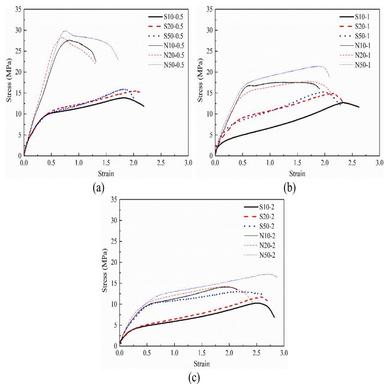
Average stress–strain curves of CNT reinforced epoxy composites with different CNT geometries: (a) 0.5%; (b) 1%; (c) 2% CNT fractions.